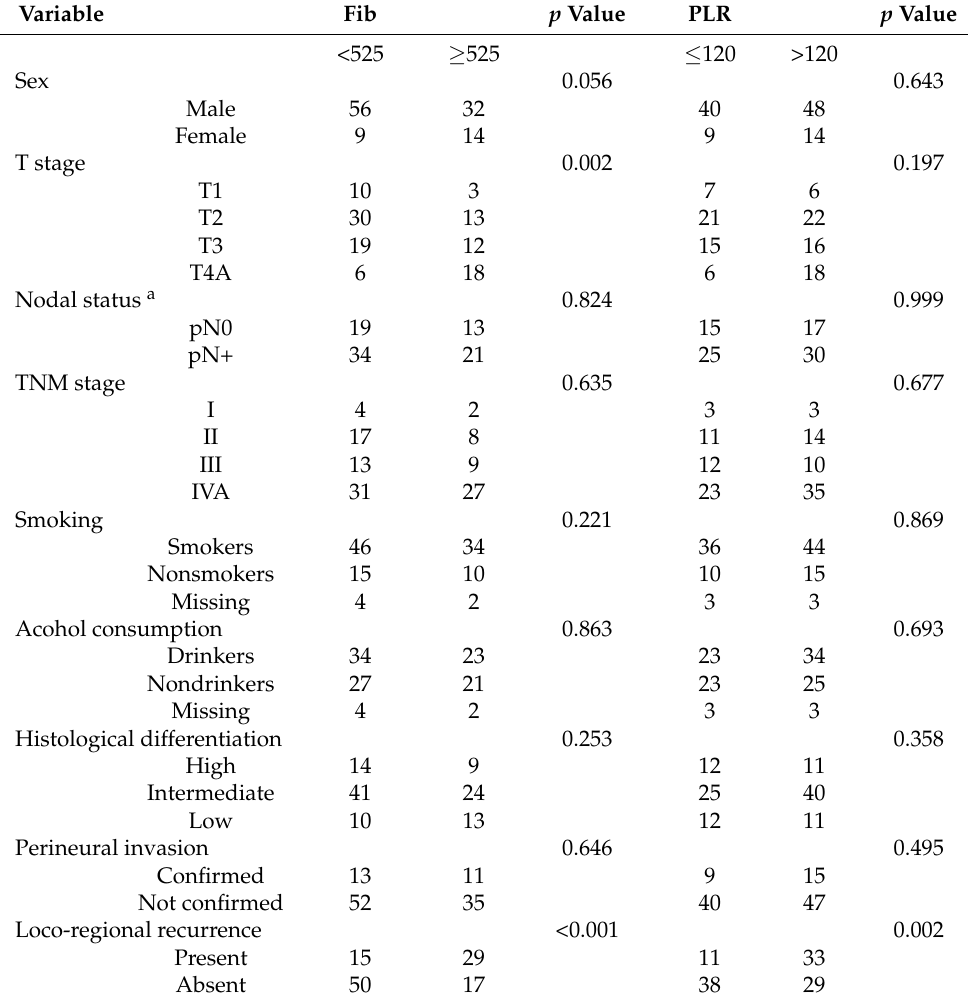
Table 3. Correlation analysis with clinico-pathological features in